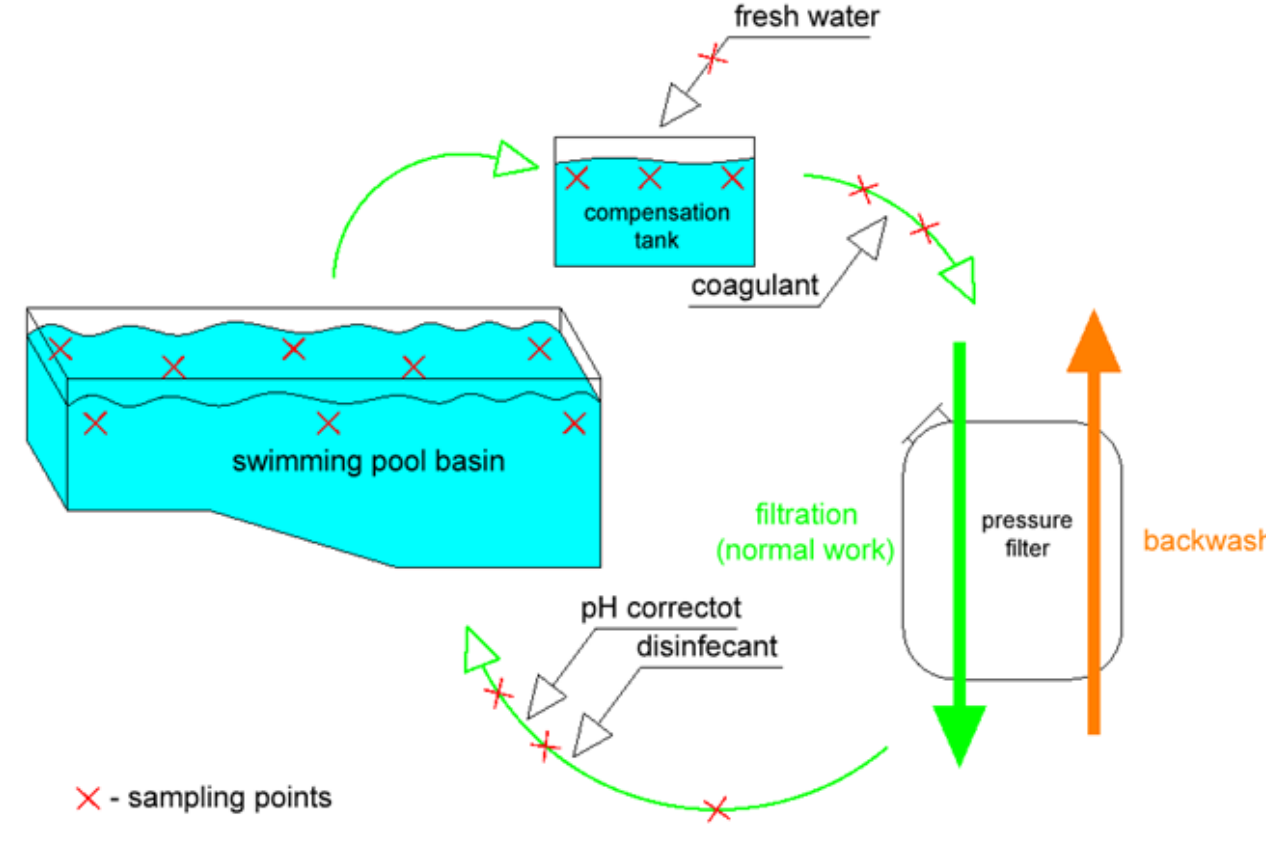
Figure 2. Sampling points of water for research.